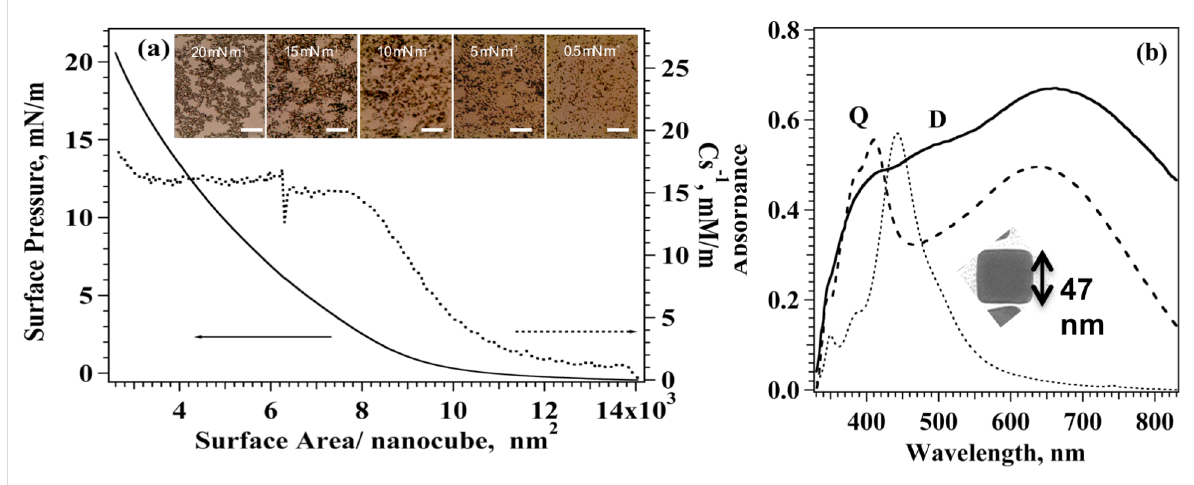
Figure 1: Procedure A. Formation of AgNC arrays by means of the Langmuir–Blodgett technique. (a) π –A and C s − 1 –A isotherm for AgNCs at the water–air interface. Optical images (650 × 750 µm) of the LB film of AgNC transferred at different surface pressures along the isotherm. (b) Absorp- tion spectra of AgNC dispersion (dotted line) of a 1 LB layer of AgNC transferred onto glass at 15 mN/m (dashed line) and 20 mN/m (solid line). Inset: Transmission electron microscopy image of a representative single